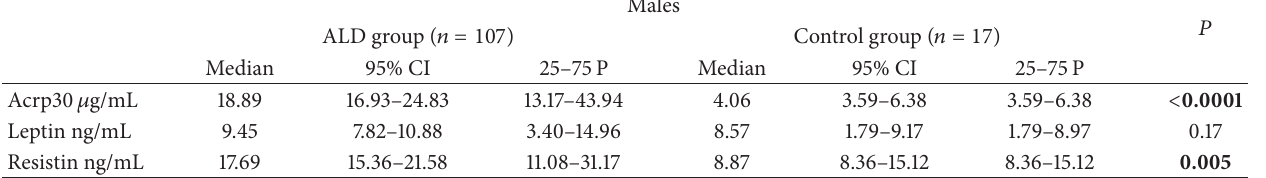
Table 4: Comparison of serum adipokine levels in females and males with ALD and the control group. Females ALD group ( 𝑛 = 40